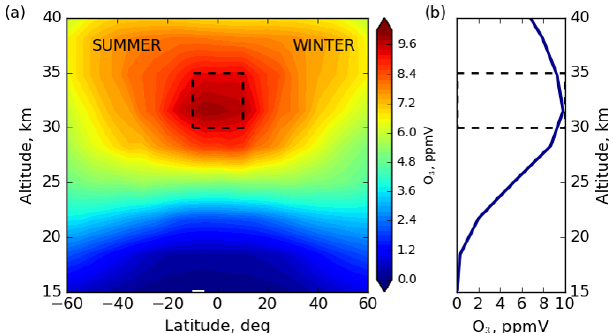
Figure 1. SCIAMACHY zonally averaged climatological mean O 3 (ppmV) for (a) latitude–altitude distribution and (b) profile during DJFs 2004–2012. The dashed rectangles indicate the region of trop- ical mid-stratosphere investigated in this